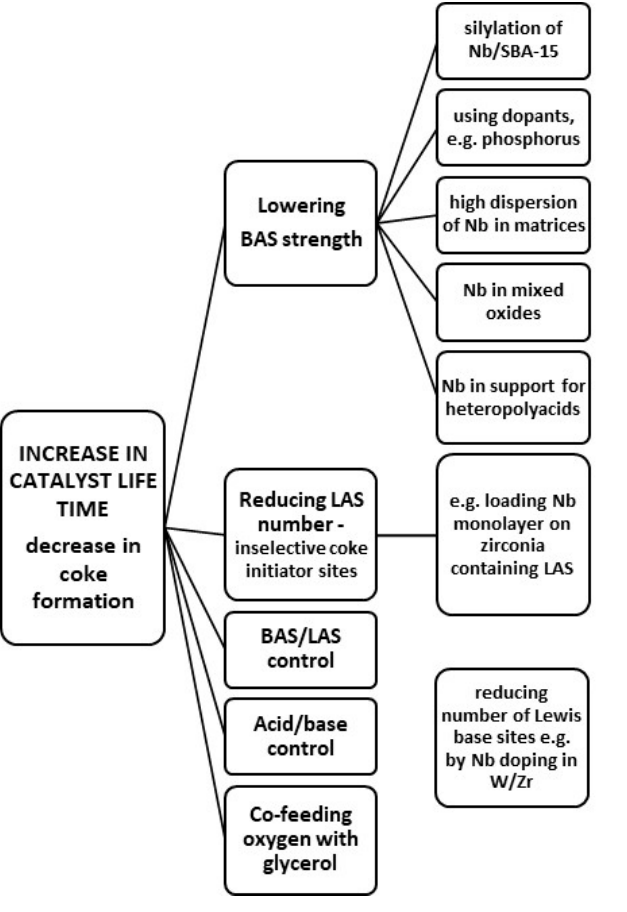
Figure 22. Selected ways leading to the increase in stability of catalysts containing niobium in glycerol dehydration.